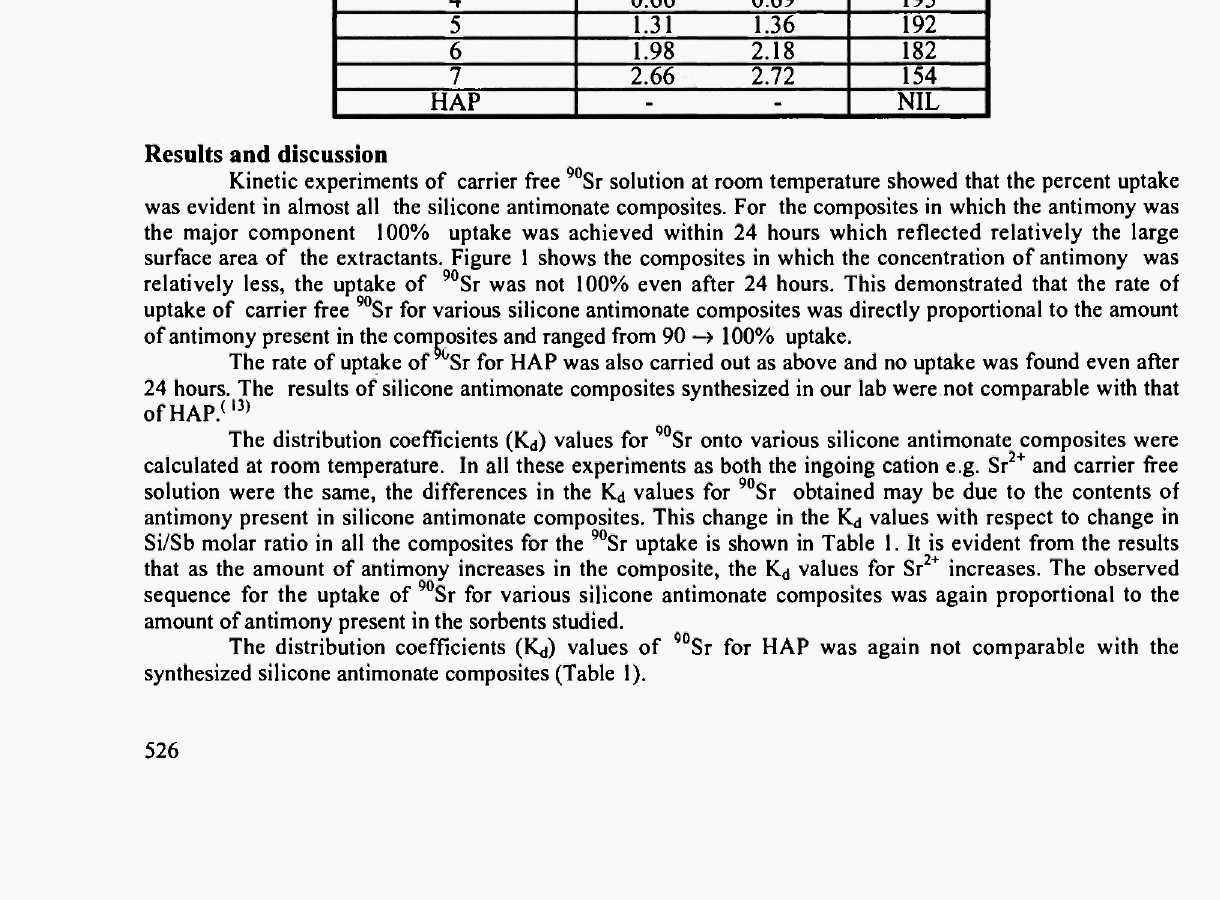
Table I: Kj values for 90 Sr onto silicone antimonate composites Composition (Si/Sb) Composites Number Theoretical